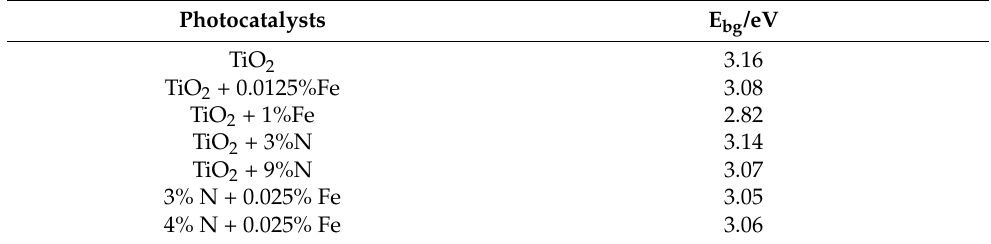
Table 3. Band gap energy values for all photocatalysts.